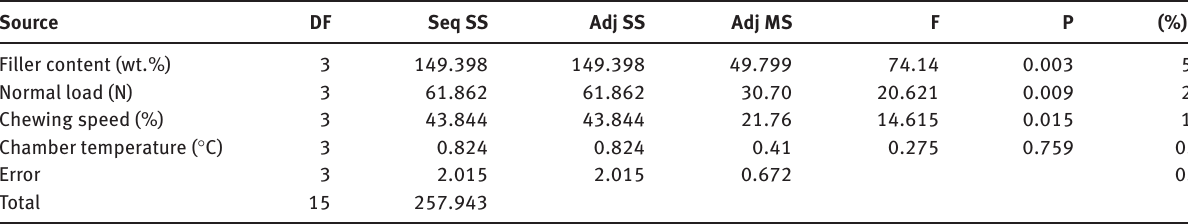
Table 4: ANOVA analysis for NADC series composite. Source Filler content (wt.%)